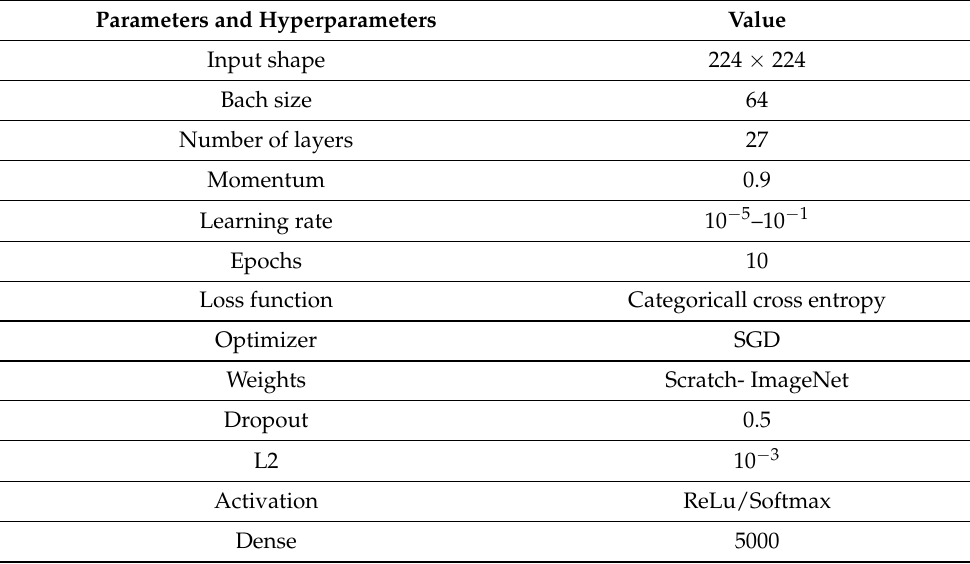
Table 1. List of parameters and hyperparameters for our